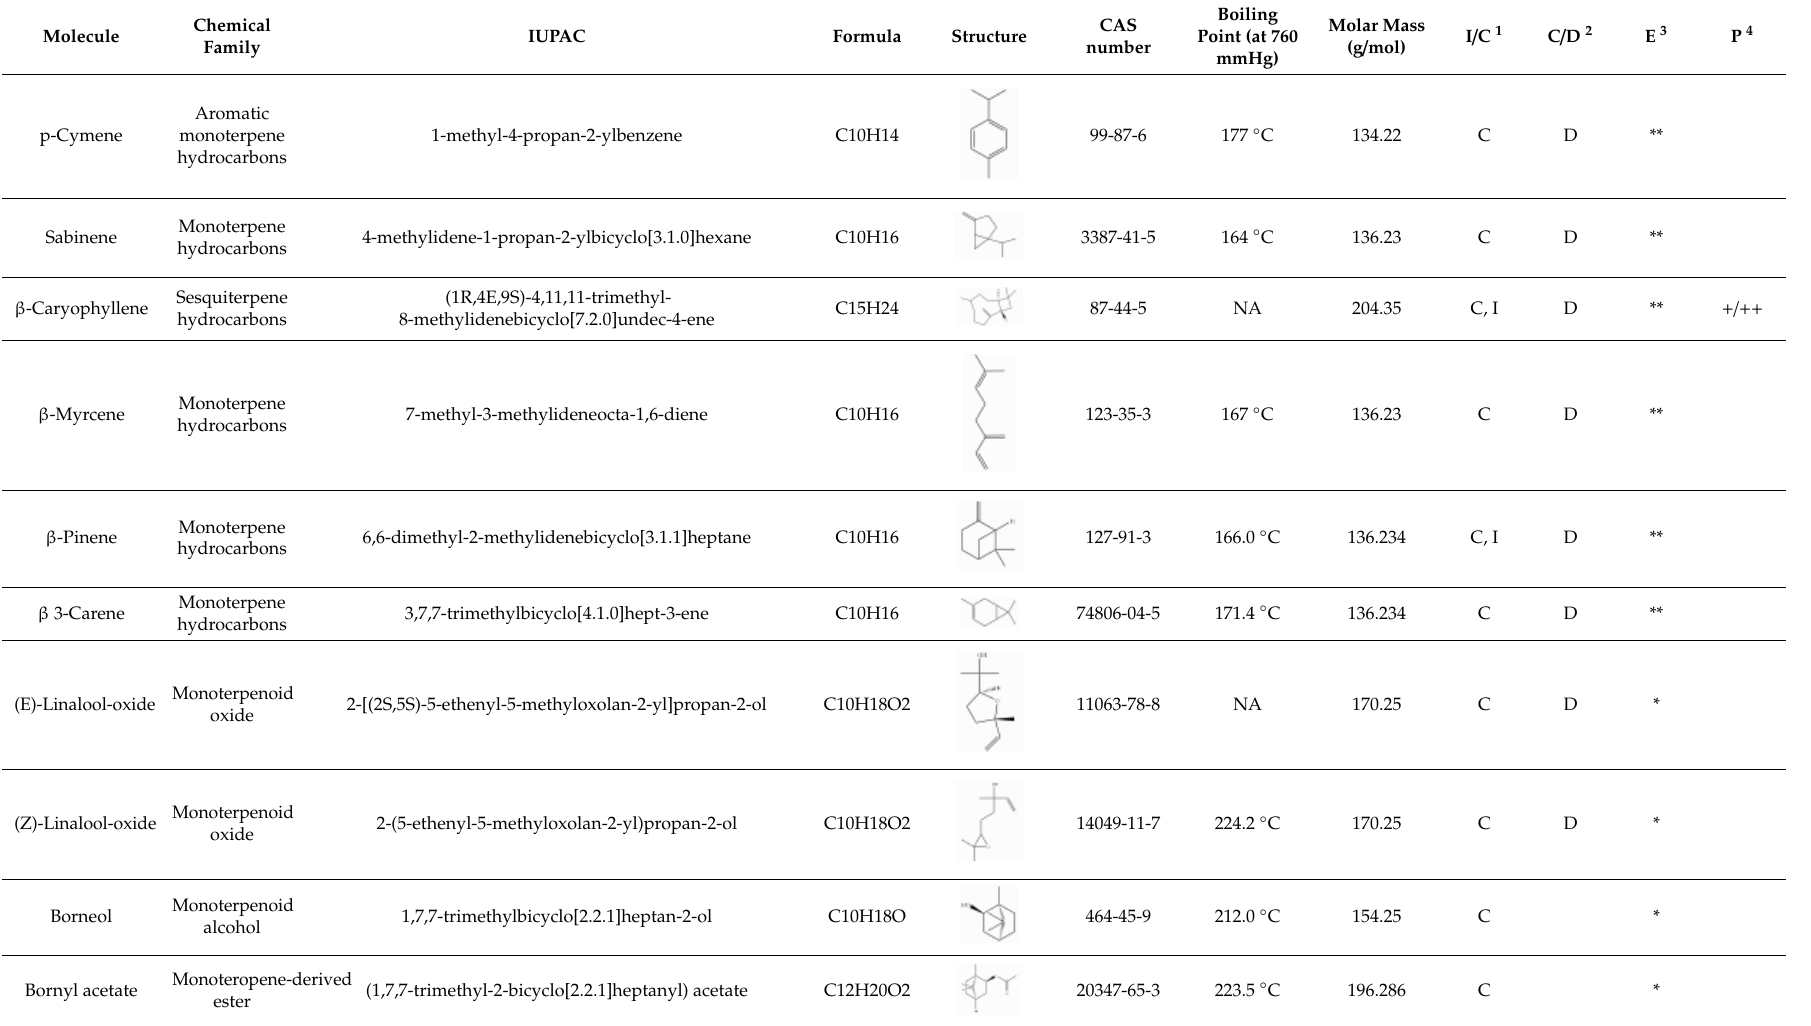
(E)-Linalool-oxide